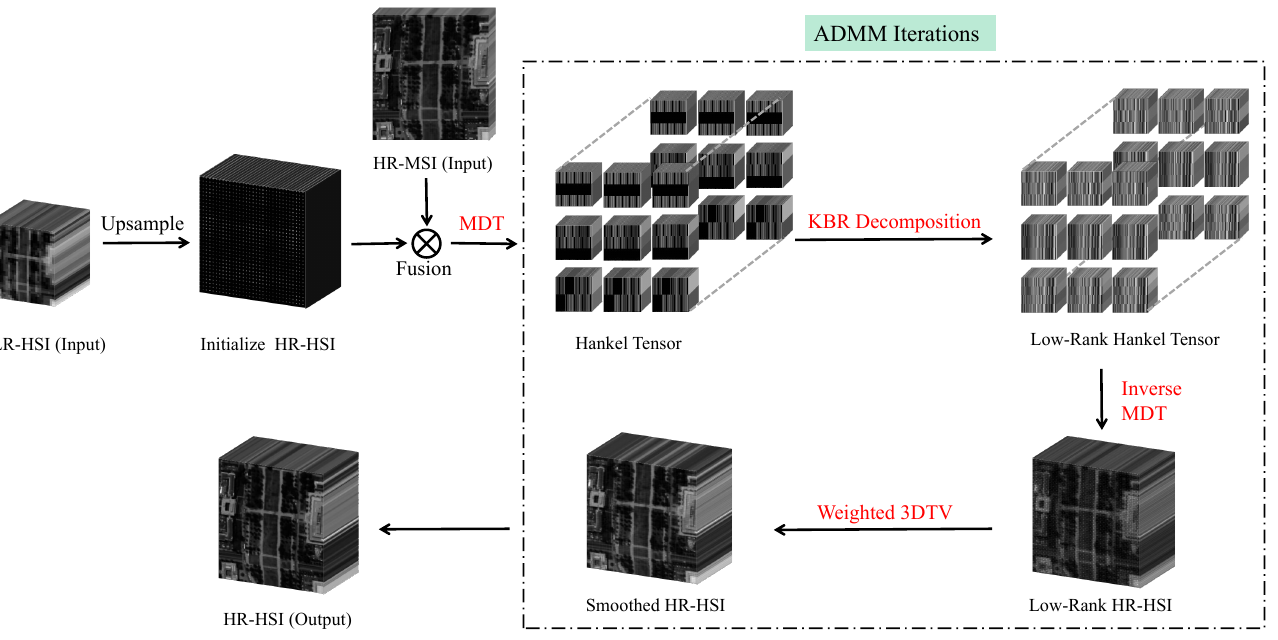
Figure 1. The framework of our HTSR